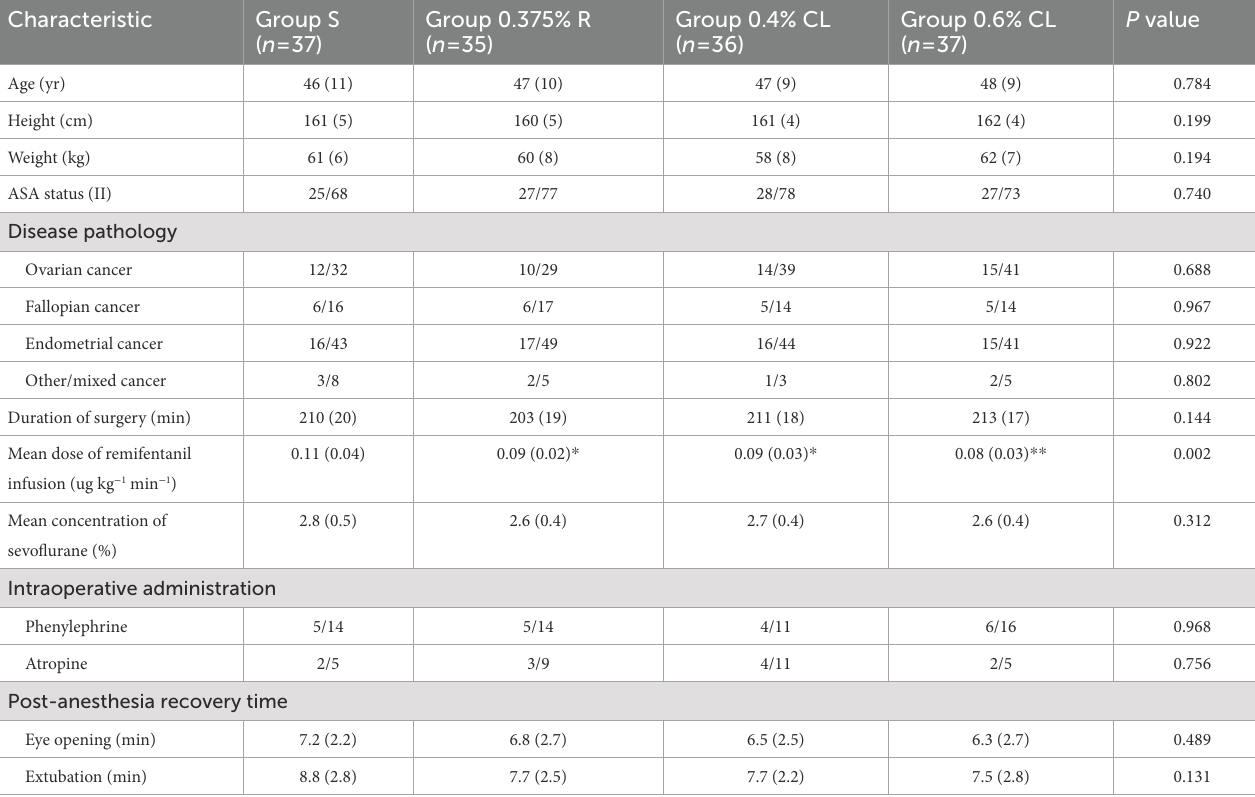
TABLE 1 Patient characteristics and anesthetic data.